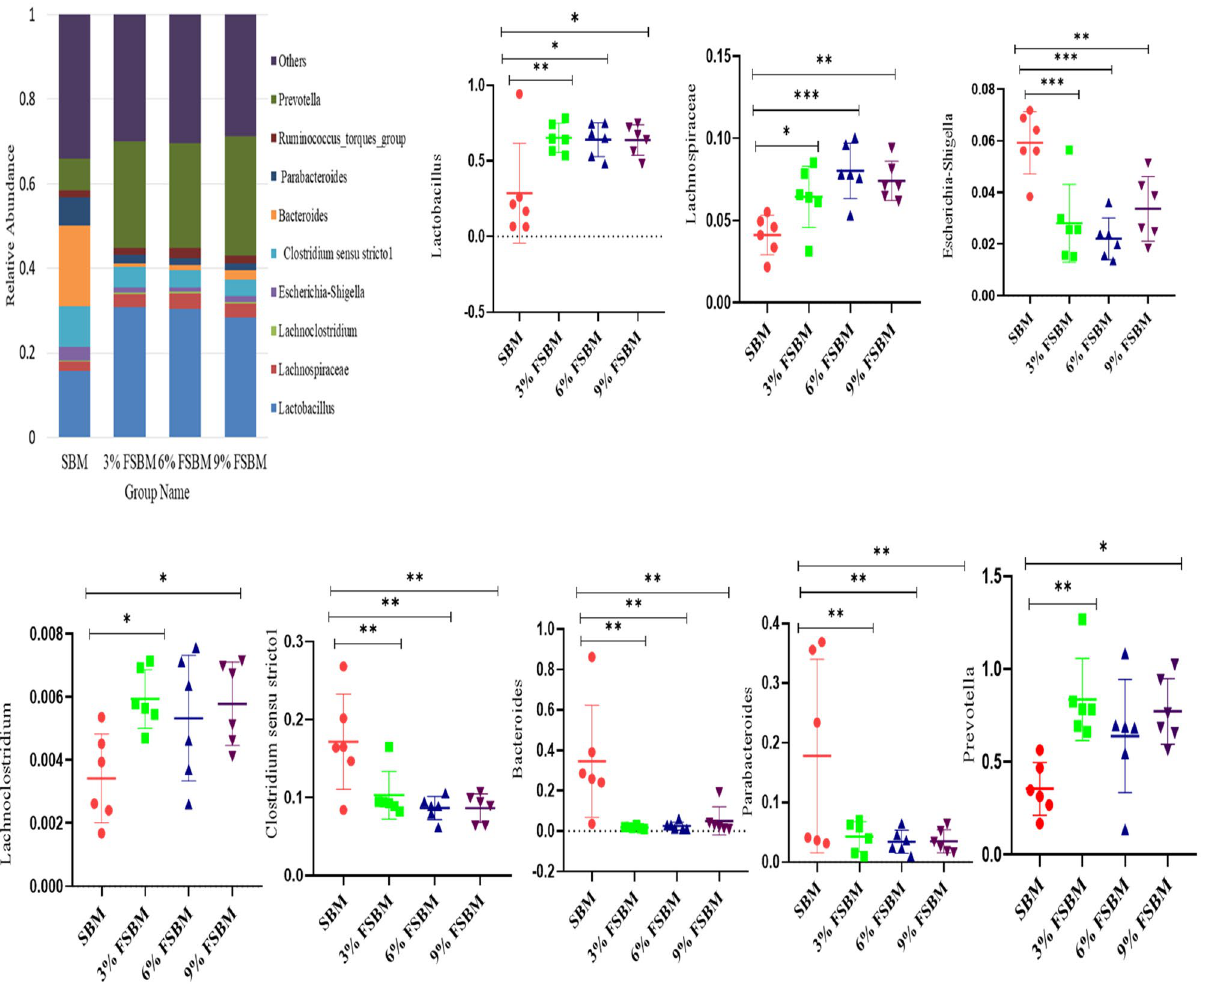
Figure 7. Effects of dietary FSBM on fecal microbial composition at the genus level. * P < 0.05, ** P < 0.01, and *** P < 0.001. SBM, soybean meal; FSBM, fermented soybean